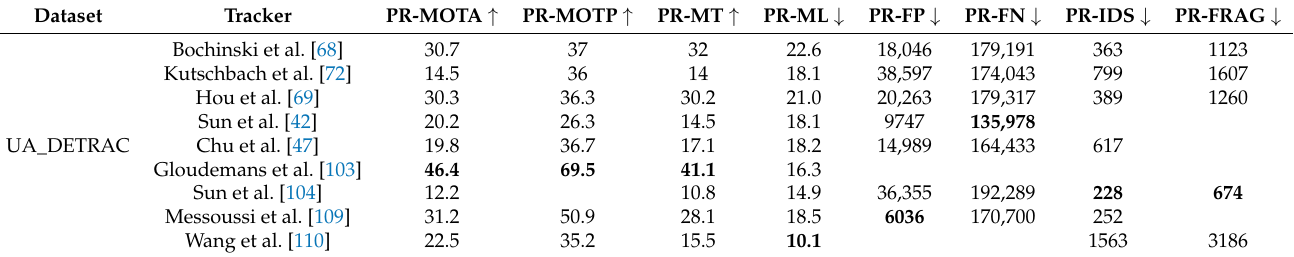
Table 7. The performance using the UA_DETRAC